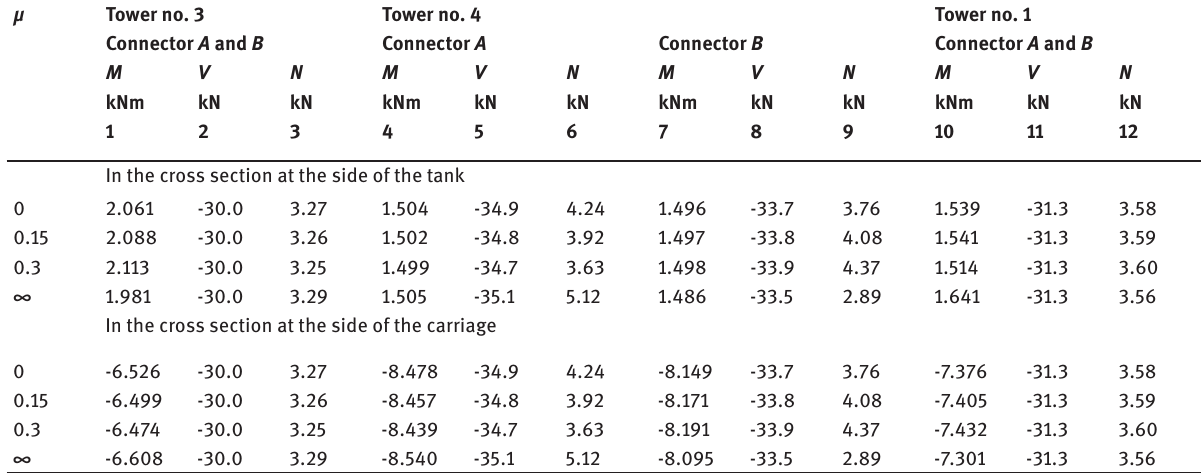
*Lifted support, removed from the model. Table 2: Internal forces in connectors for the towers without cantilevers: wind W2. µ Tower no.